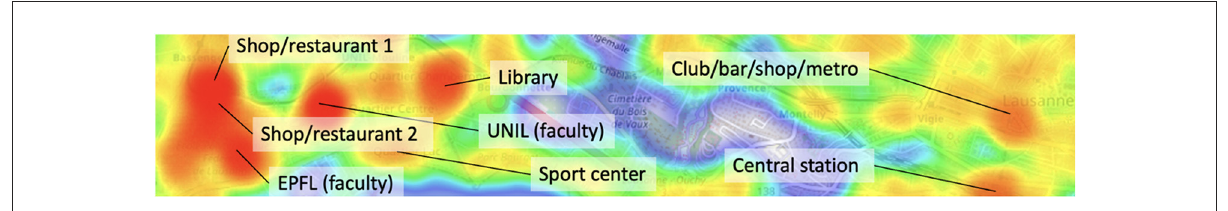
FIGURE6 Heatmap of the GPS data available in the dataset and location of the POIs analyzed in this